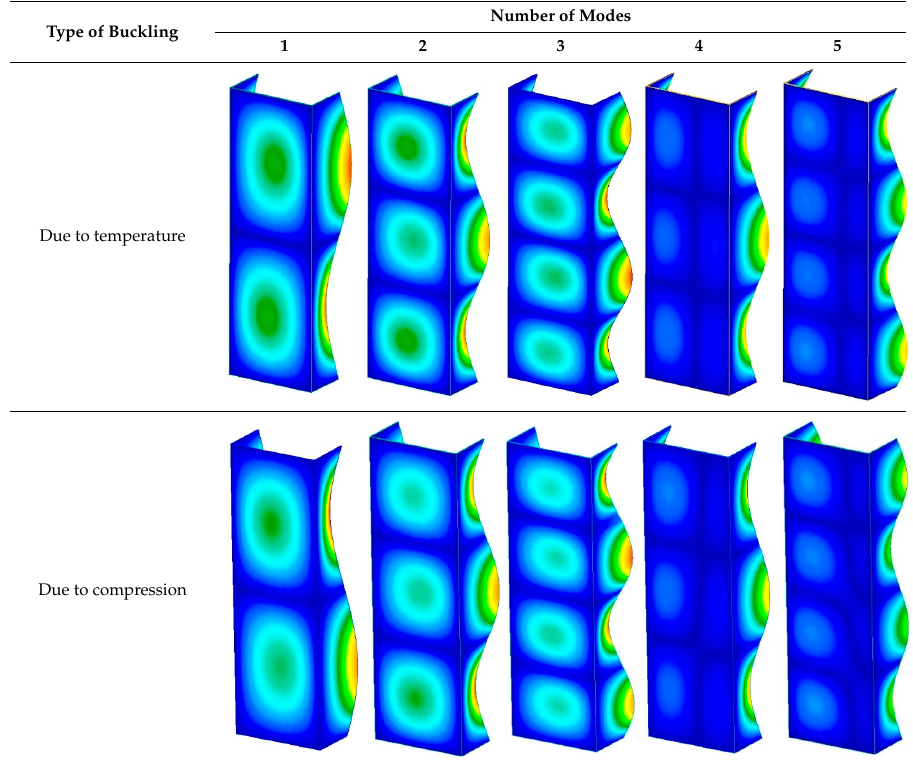
Table 3. The buckling modes of the columns.